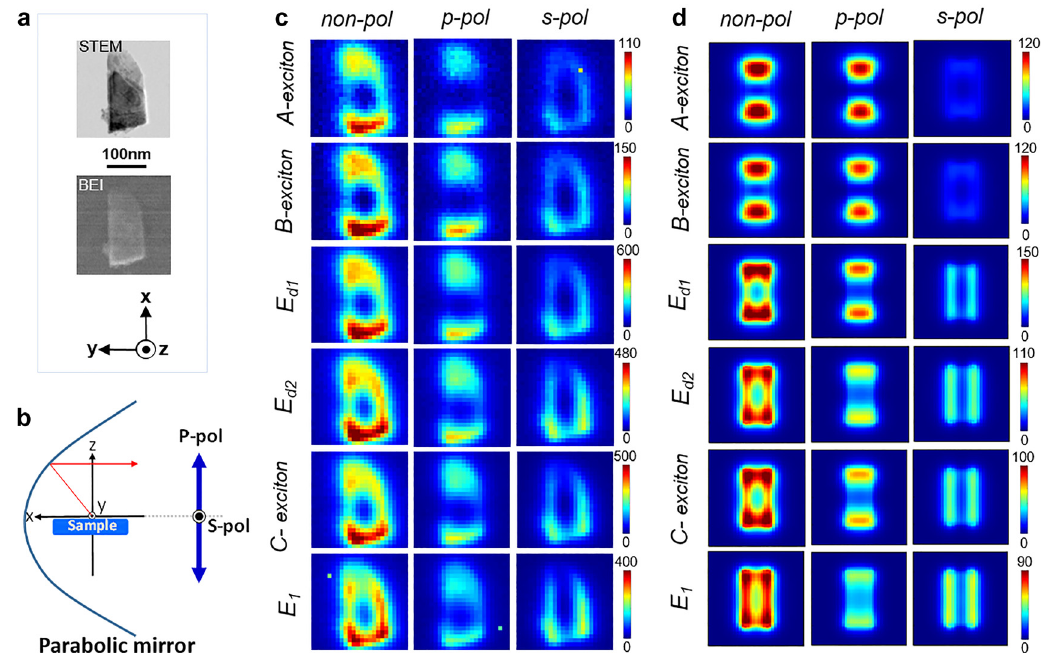
Figure 4: Experiment and BEM simulation CL maps. (a)STEMbrightfieldandBEIimagesofarectangularflakewithalengthof ∼ 200nmandwidthof ∼ 100nm.Thecoordinate fi xedattheparabolic mirror is also displayed. (b) Schematic illustration of CL system setting. The CL signal is collected in all the angles. (c) Experimental CL maps withoutspectraldeconvolutionfornon-,p-ands-polarizationsrespectivelyfromthelefttotheright.(d)ThecorrespondingBEMsimulationfor non-,p- ands-polarizations. For bothsimulationand experiment results,CLmaps displayemissionsof A-exciton, B-exciton,dielectricmodes E d 1 and E d 2, C -exciton and transition energy E 1 , respectively, from top to